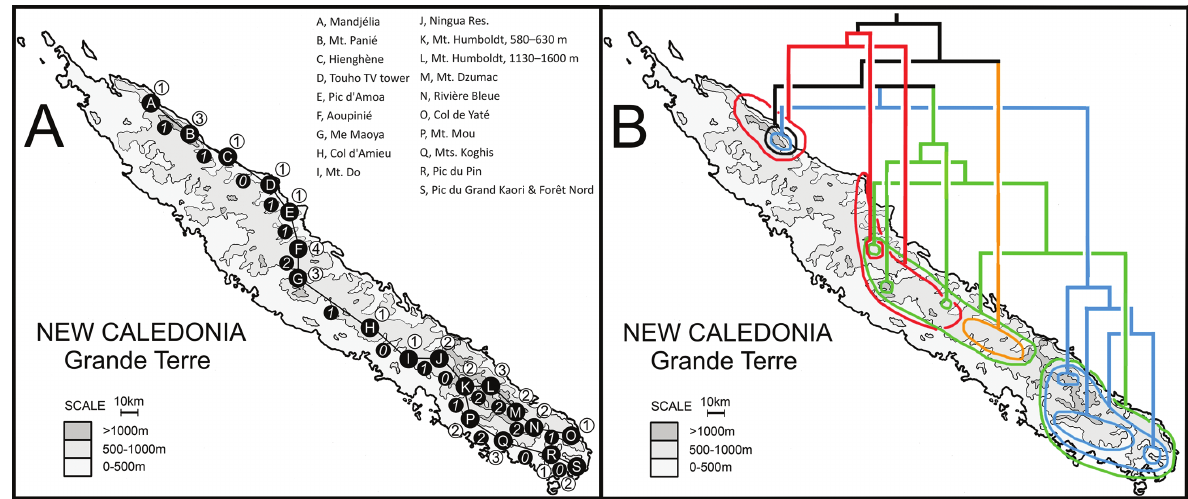
Figure 27. Distributional attributes of New Caledonian subgenus Phacothorax spp.: A , recorded species richness (open circles) at principal collecting localities represented in this revision (A–S), and species shared between adjacent localities (filled circles and italicized numerals) – see text regarding parallel networks of collection localities in southern end of Grand Terre; B , chorologically oriented cladogram of subgenus Phacothorax spp. (Fig. 7) with species terminals corresponding to areas of distribution, and the five monophyletic or monobasic constituent lineages spectrally colored red, orange, green, blue, and black (after Sharma & Giribet